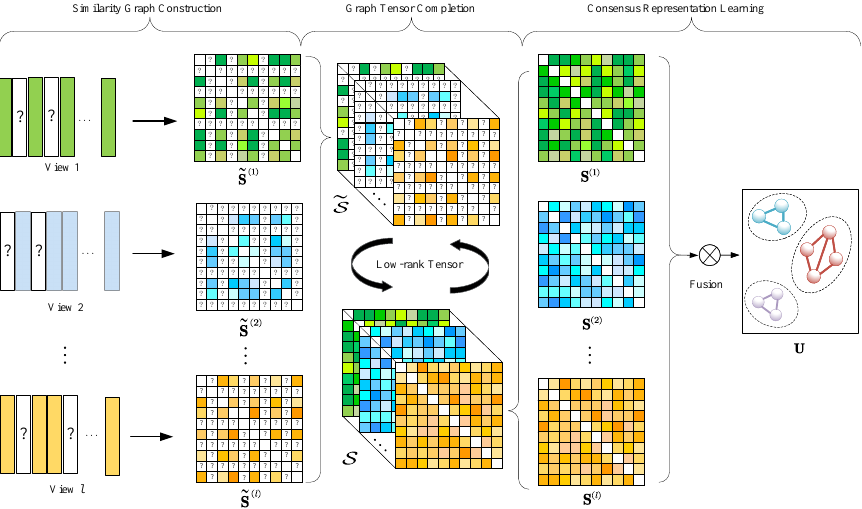
Figure 1. Framework of the proposed incomplete multi-view clustering method, integrating the graph completion and consensus